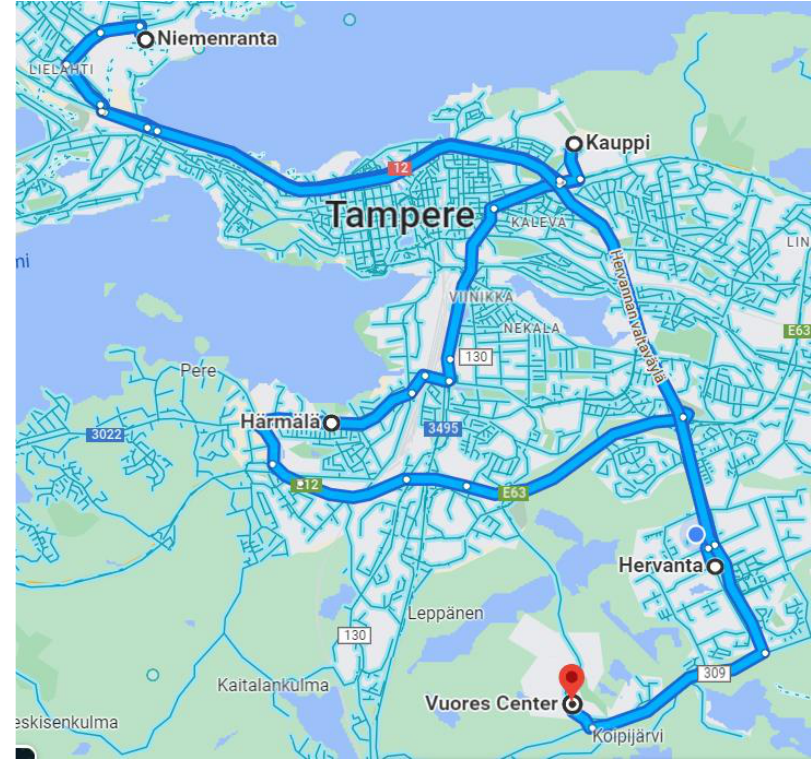
Figure 1. Hervanta, Härmälä, Kauppi, Niemenranta, and Vuores on the